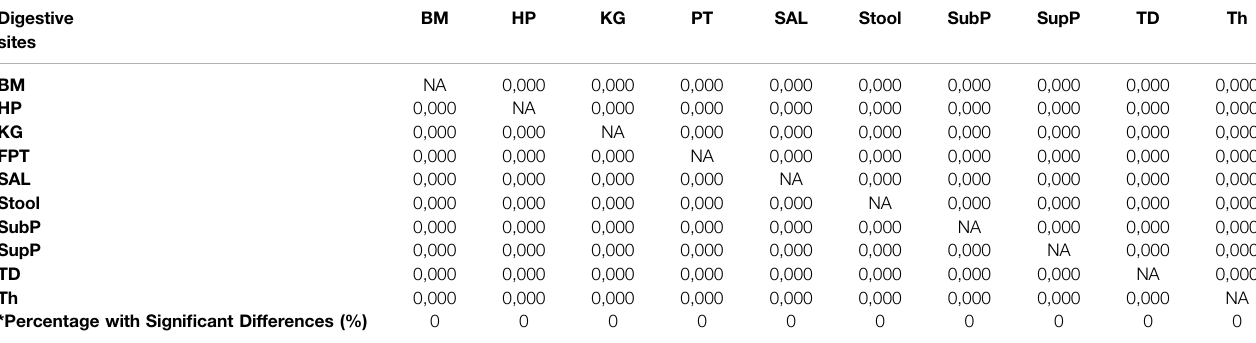
TABLE 1 | Summary of the randomization tests from Supplementary Table S7 : the pair-wise comparisons of the DAR parameter ( z ) among the ten DT sites of the human digestivemicrobiome(atGenustaxonlevel),each digitofthecode( e.g ., “ 0,000 ” )represents theresultofrandomization testforeachdiversityorder q (cid:1) 0,1,2,3. ‘ 0 (cid:1) no signi fi cant difference, “ 1 ” (cid:1) signi fi cant difference. Digestive sites